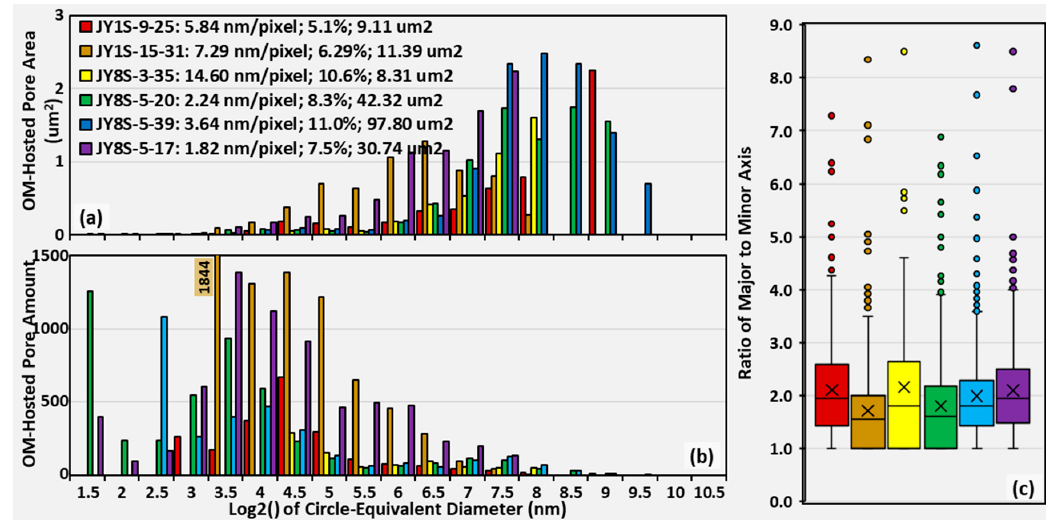
Figure 11. The pore size distribution (PSD) and geometry of OM-hosted pores within the second subtype of weakly or undeformed porous pyrobitumen (OM IV) of Longmaxi-Wufeng Shale, Eastern Sichuan Basin. ( a ) PSD determined by pore sectional area; ( b ) PSD determined by pore amount; and ( c ) the ratio of the major to the minor axis. The three values after image ID in the legend are the image resolution (nm/pixel), organic porosity (%), and OM sectional area (µm 2 ). The number labels show the values that are beyond the range of the vertical axis.